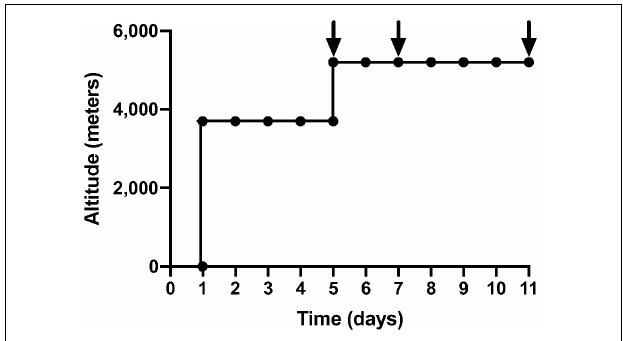
FIGURE 1 | Ascent profile of APEX 2 expedition: black arrows indicate sampling on day 1, 3, 7 of 7 consecutive days at an altitude of 5,200 m.